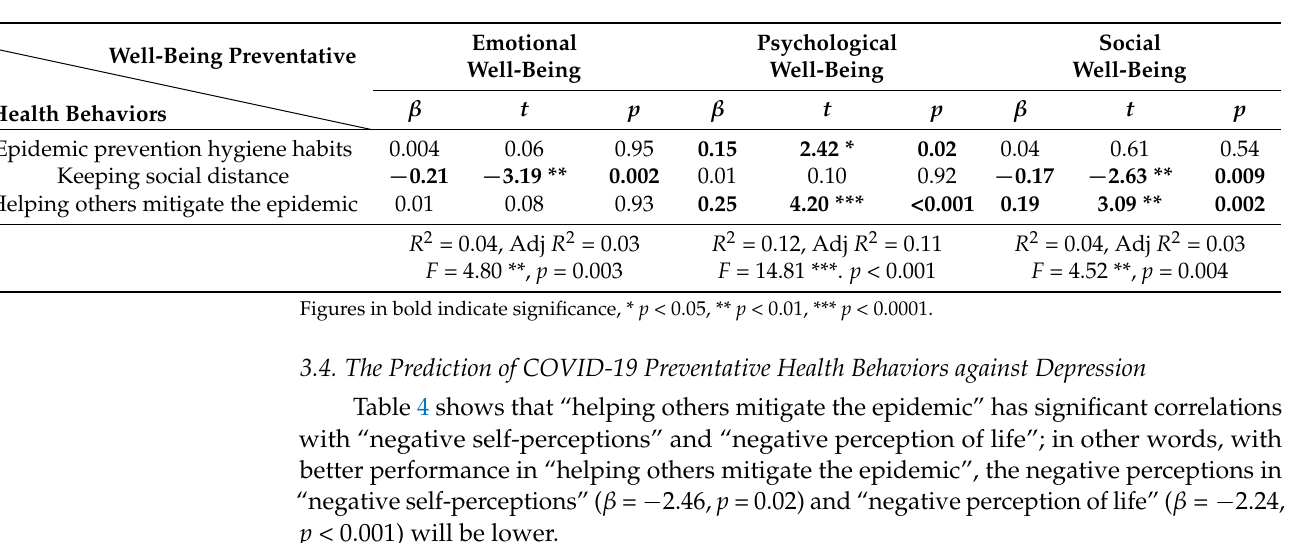
Table 3. Regression results of COVID-19 preventative health behaviors to